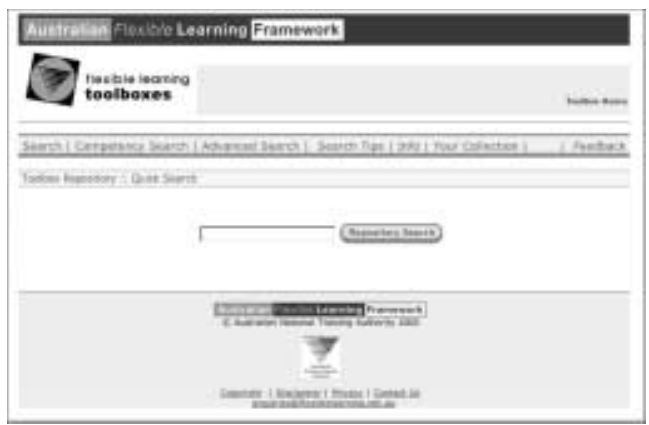
Figure 2. The Flexible Learning Toolbox digital repository facilitating the discovery and reuse of learning resources (http://flexiblelearning.net.au/search.asp) (Flexible Learning Advisory Group,